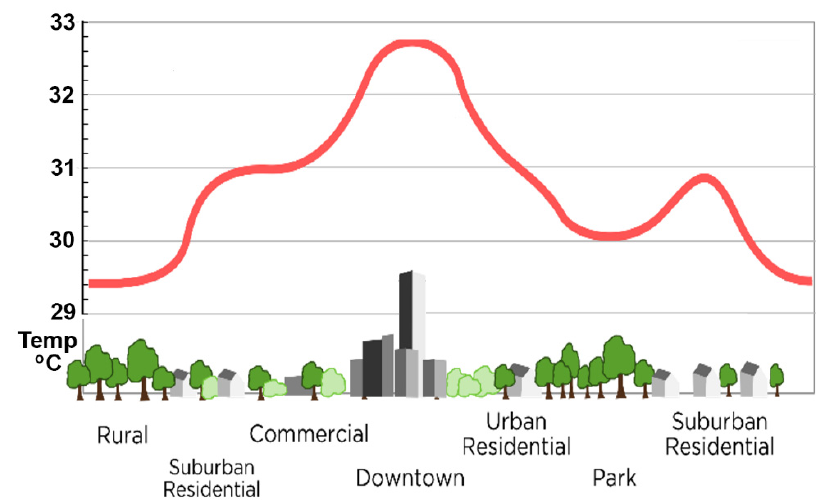
Figure 10. The typical urban heat island profile (credit to NOAA). http://www.crh.noaa.gov/im-